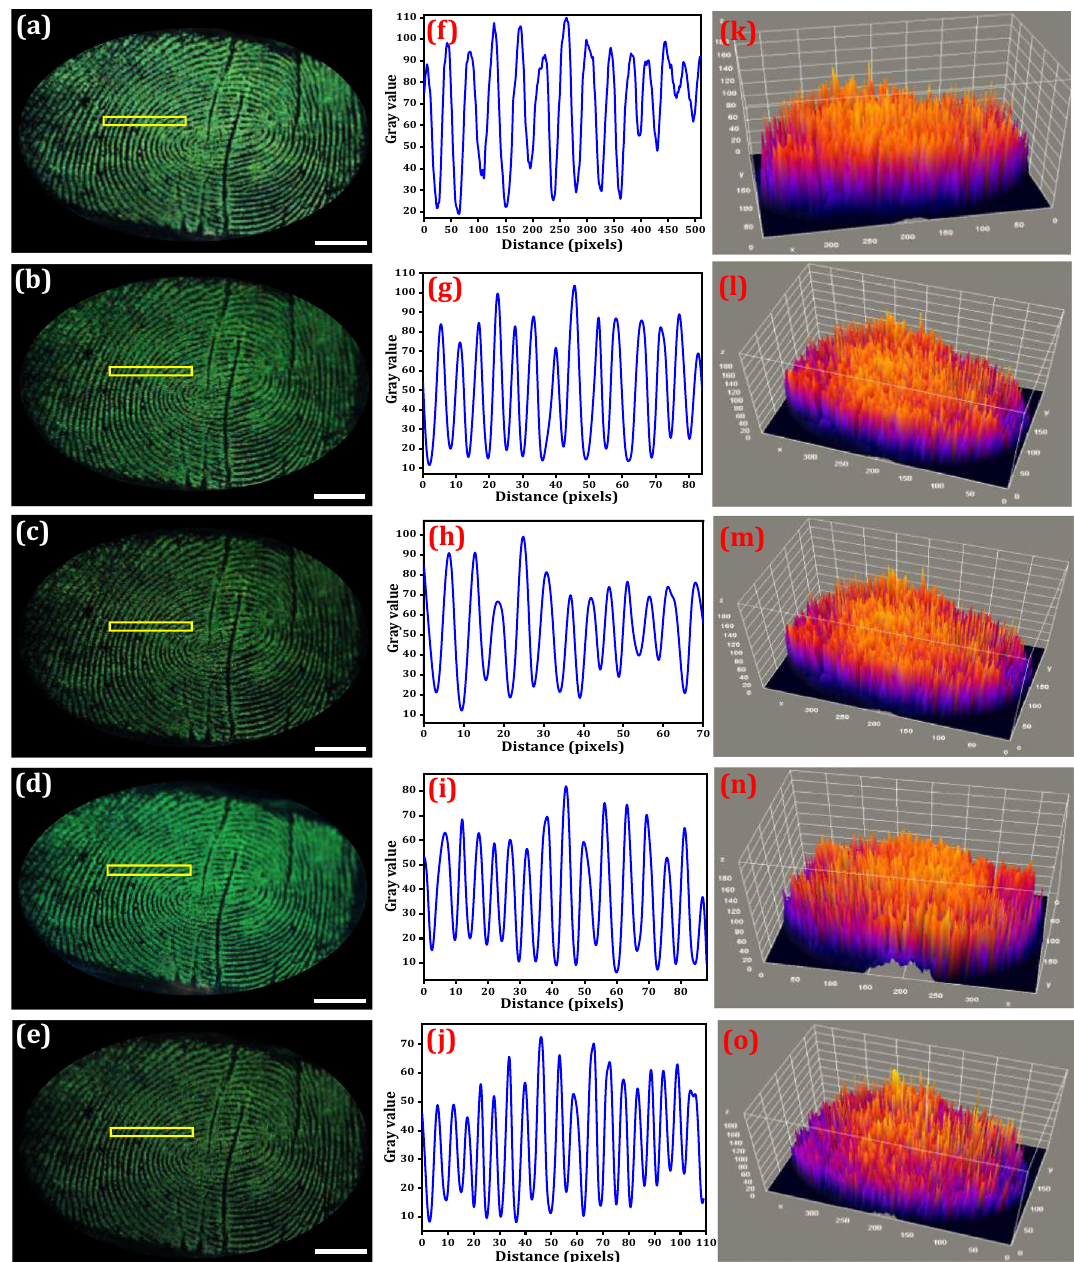
Figure 7. LFPs on the glass surfaces aged for different time periods and visualized using optimized NPs under UV 254 nm light exposure ( a ) 0 day, ( b ) 6 days, ( c ) 12 days, ( d ) 18 days, ( e ) 24 days; ( f – j ) Pixel plots yellow box region of the corresponding FPs of ( a – e ); ( k – o ) 3D interactive plots of the corresponding FPs of the same row (Scale bar: 5 mm). Figures ( f – o ) are generated using ImageJ software 1.8.0_172 (https:// imagej. nih. gov/ ij/ downl oad. html